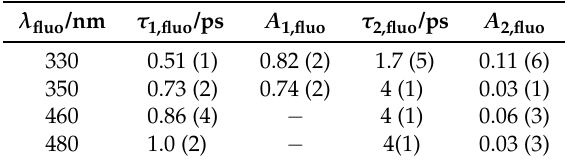
Table A3. Decay times τ i and relative amplitudes A i from the analysis of the fluorescence up-conversion measurements for XMP − after excitation at λ pump = 260 nm (2 σ error limits of last digits in parentheses).